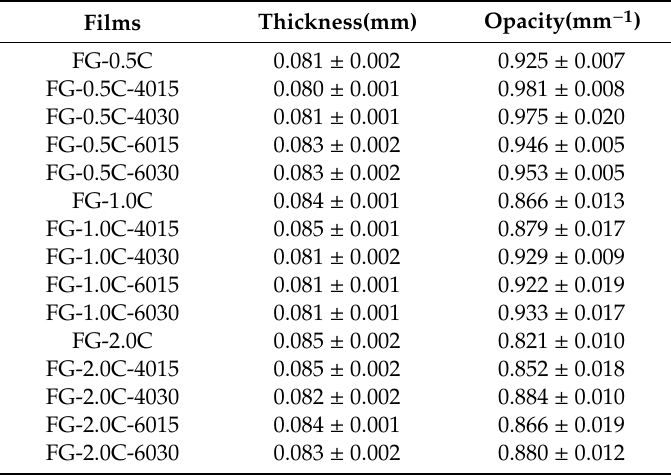
Table 4. E ff ect of sonication on the opacity of flaxseed gum films incorporated with carvacrol. Films